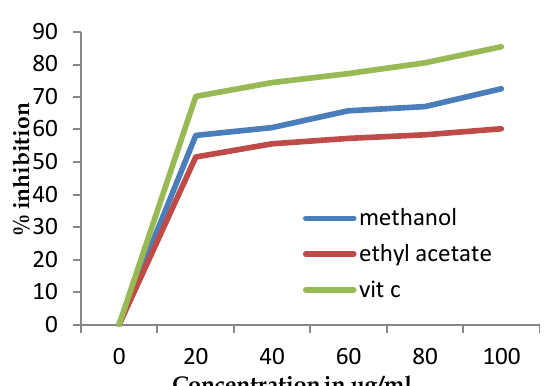
Figure 1 : DPPH scavenging activity of leaf extract of Bryophyllum pinnatum Methanol : Y = 11.26x + 14.56: R 2 = 0.612 VIT C: Y =13.16x +18.48: R 2 = 0.590 Ethyl acetate: Y = 9.231x+ 14.84: R 2 = 0.550